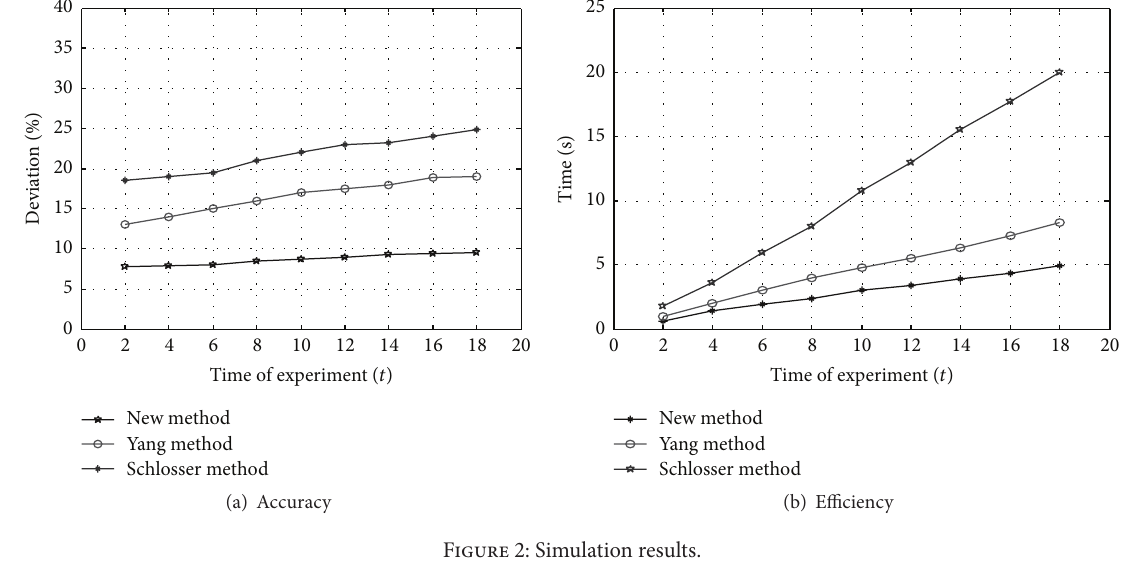
Figure 2: Simulation results.